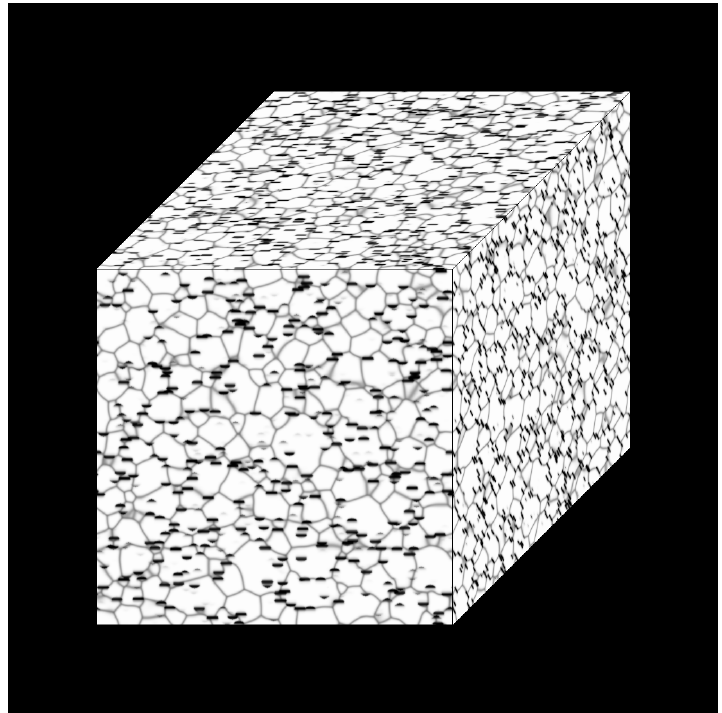
Figure 2. Grain structure with 3 vol% volume fraction at 14,000 ∆ t . All hydrides are aligned along one direction (one crystallographic variant). The system contains 3357 grains, and the average grain radius is 15.799. The volume of each hydride is the same.